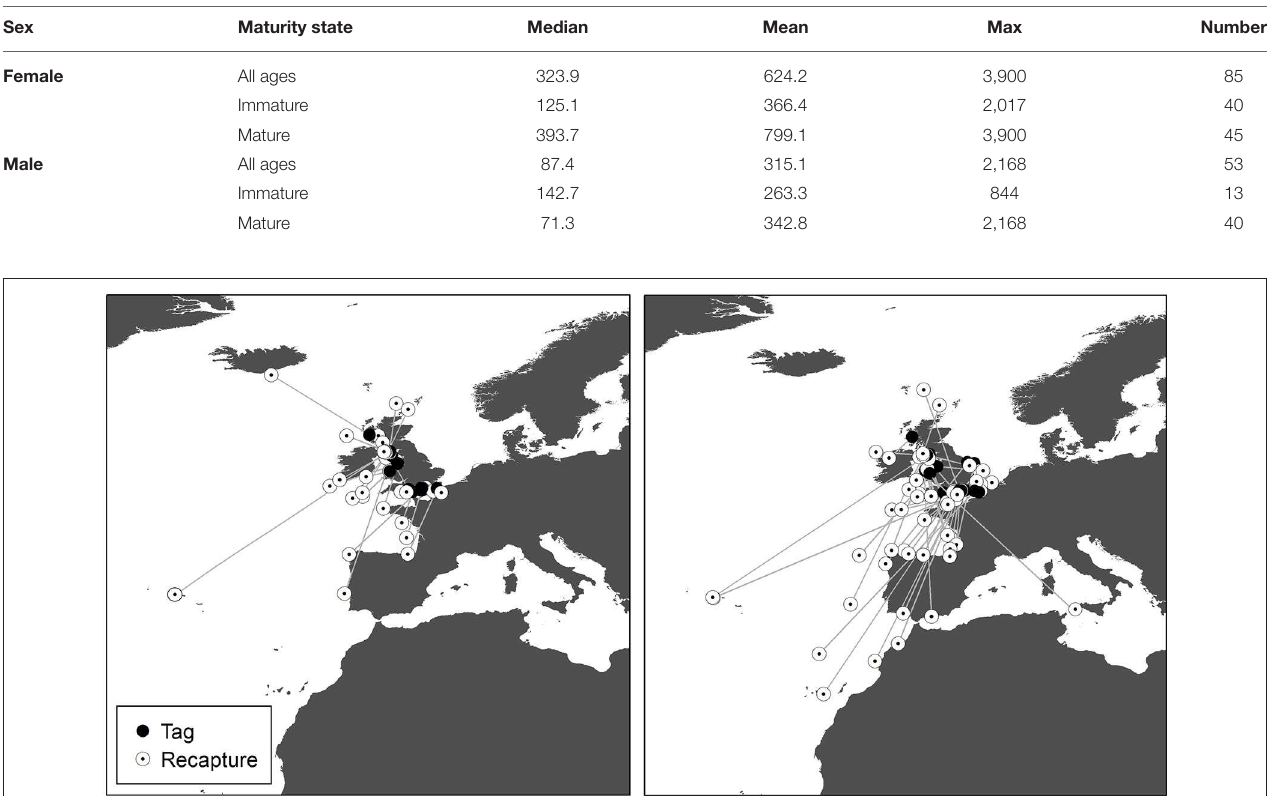
FIGURE 4 | Recaptures of tope tagged around the UK from the Scottish Shark, Glasgow Museums and UK Shark Tagging Programmes with a straight-line connector. Left , male; Right , female.